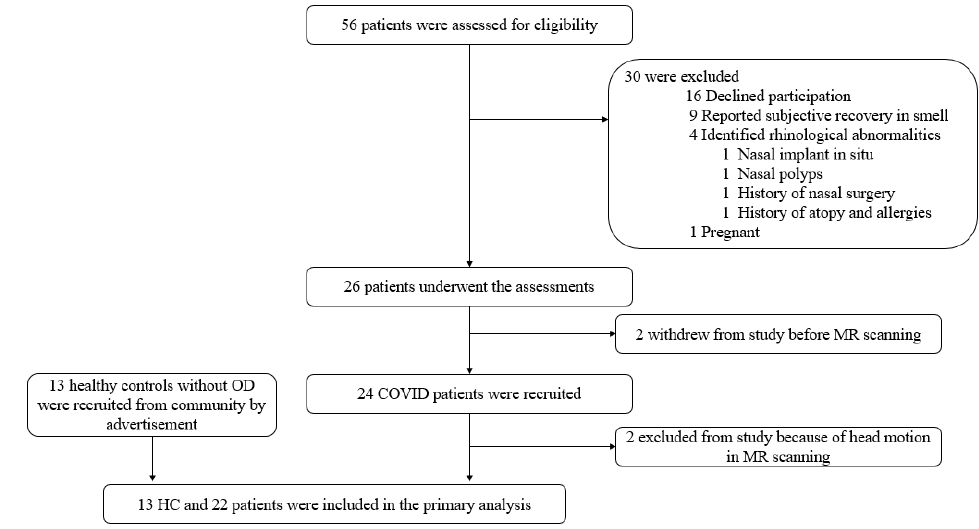
Figure 1. Flow diagram showing the subject recruitment process in this study.